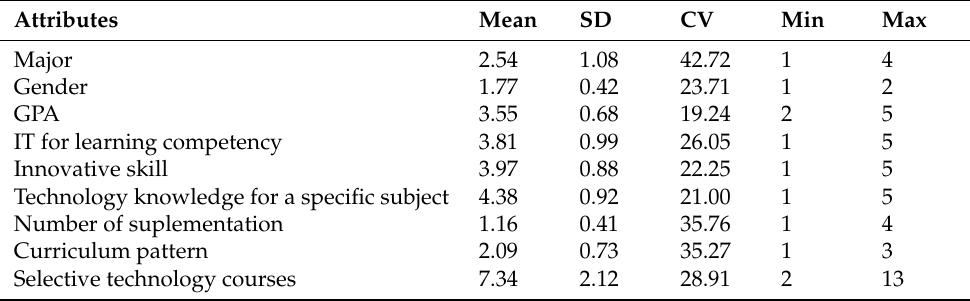
Table 1. Overview of all attributes used to train the